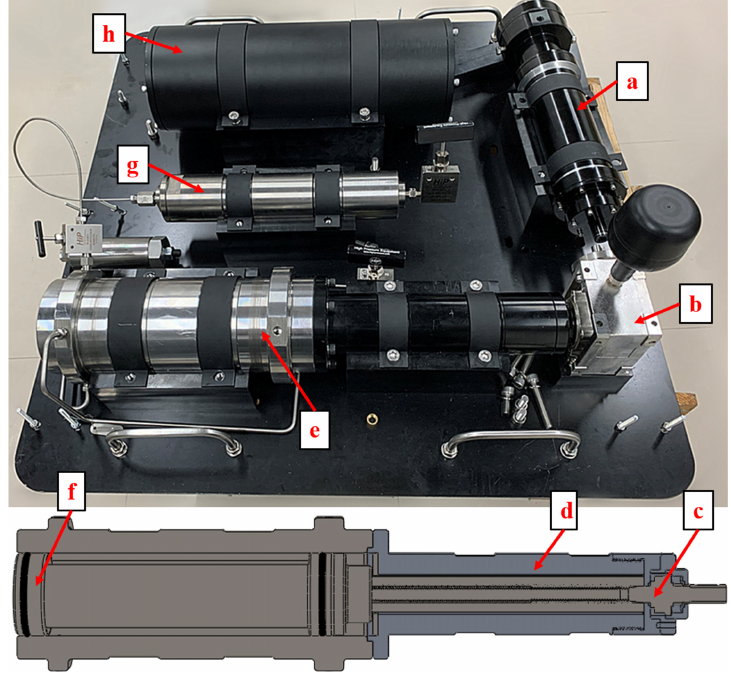
Figure 1. The prototype of the pressure-maintaining trapping instrument (PMTI).